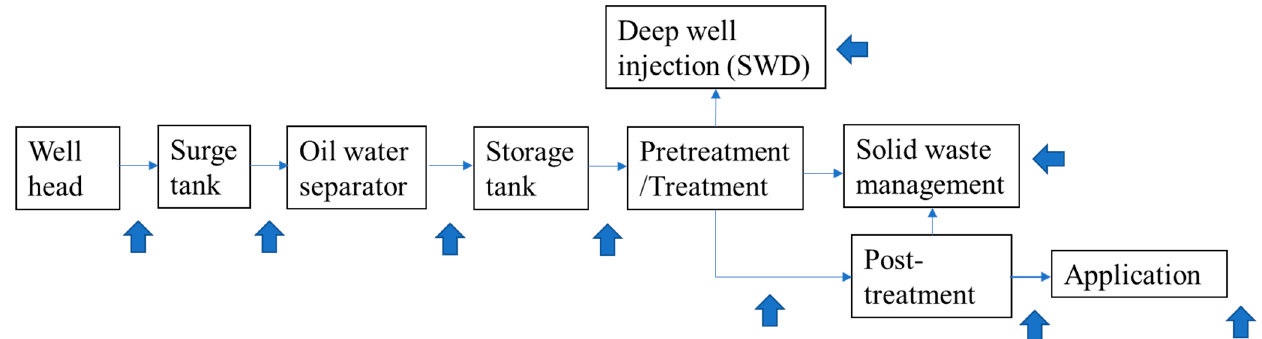
Figure 3. Example of water sampling and analysis locations and tiers.